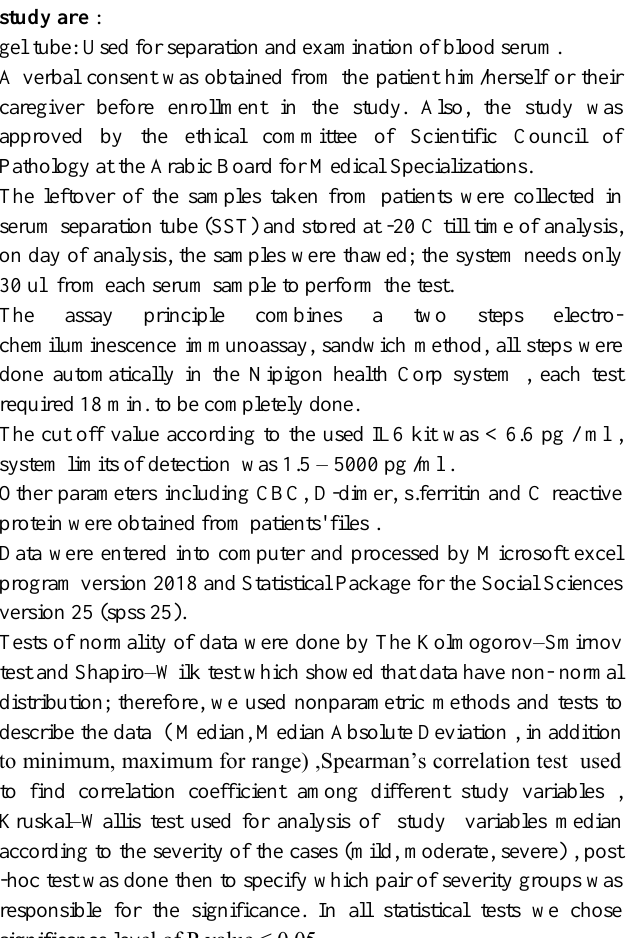
Table 2: Statistical correlations between the 3 groups of patients according to the severity of the disease regarding age and hematological